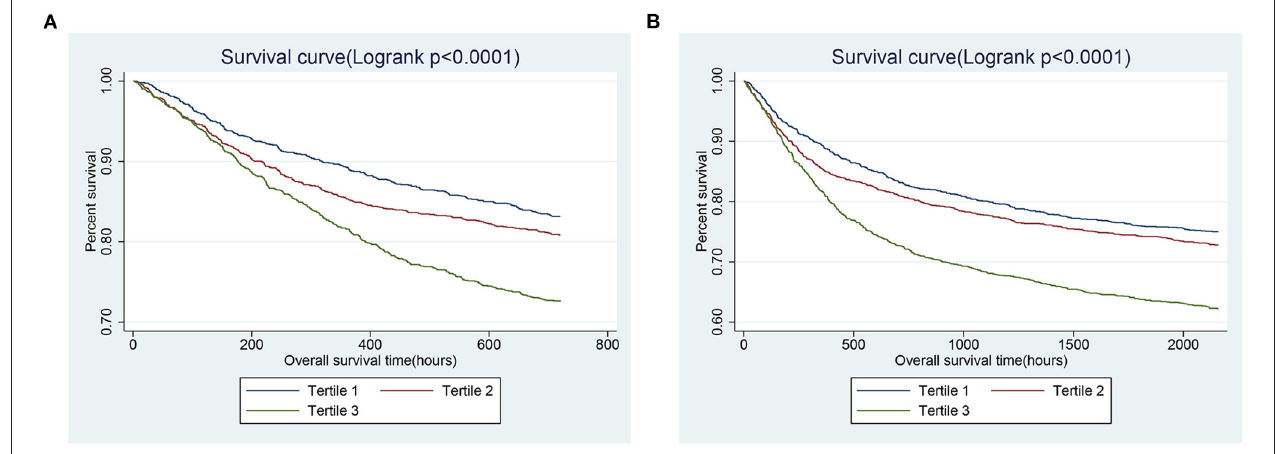
FIGURE 3 | Kaplan-Meier survival curves showing the 30- (A) and 90- (B) day all-cause mortalities stratified by SII tertile in critically ill patients with CHF. SII, systemic immune-inflammation index. CHF, congestive heart failure.